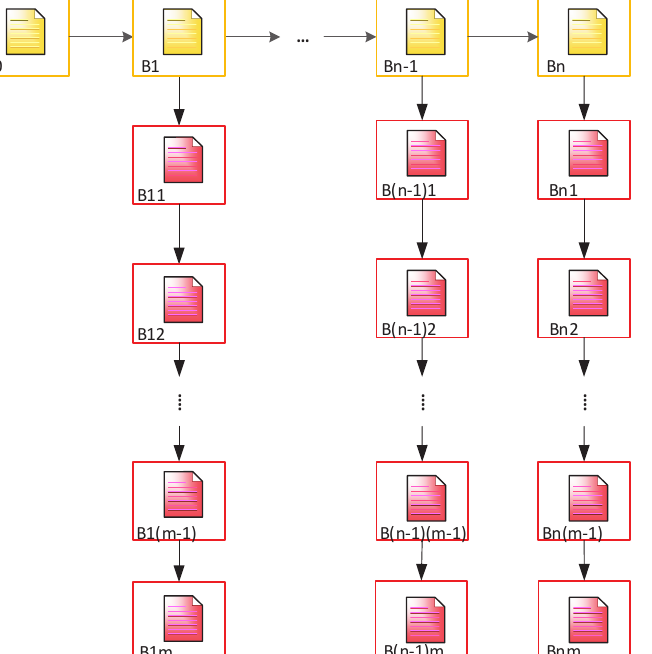
Figure 8. Generalized structure of ID-card processor.